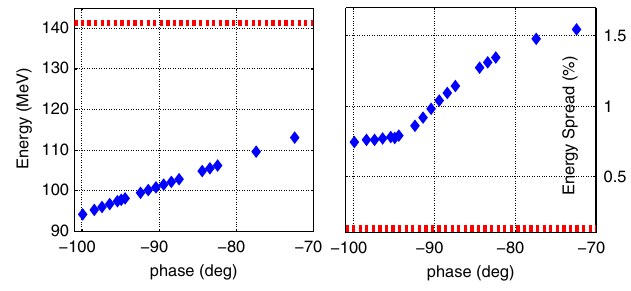
FIG. 5. Simulation ( PARMELA ) of energy and energy spread as a function of compression phase for a 280 pC beam in the SPARC photoinjector. Red dotted lines show the values relative to the on-crest acceleration.